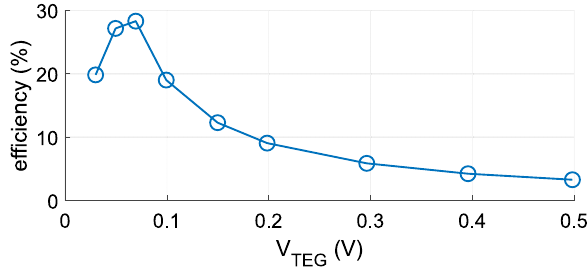
Figure 9. LTC3109 efficiency according to input voltage V TEG